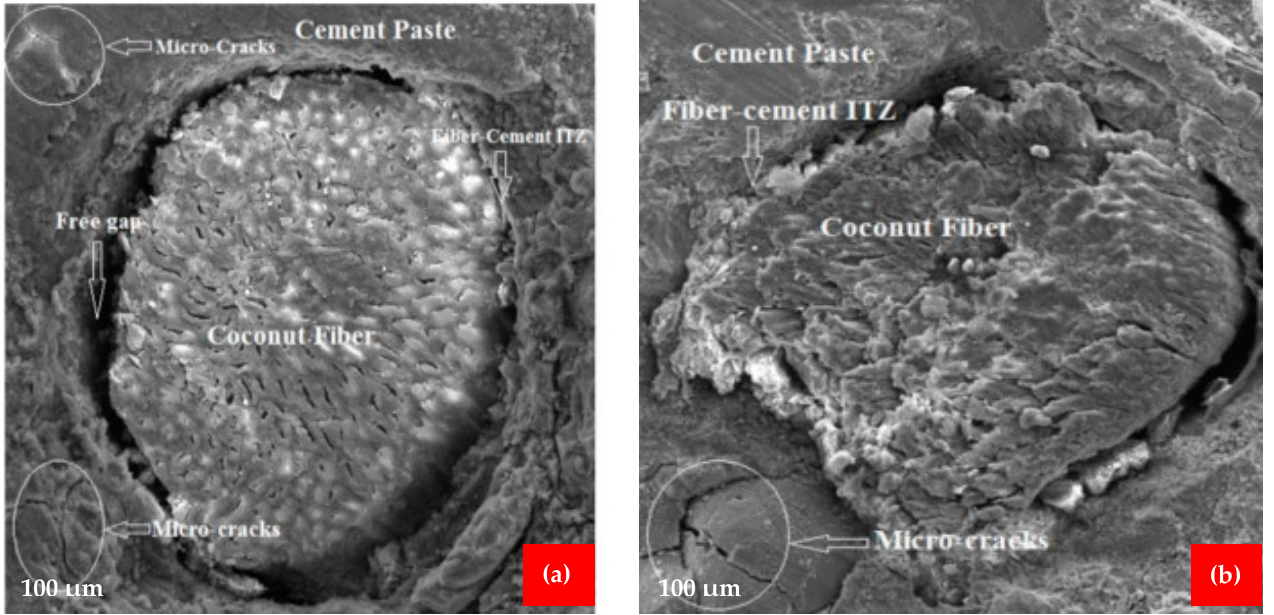
Figure 16. SEM of ( a ) free space between cement paste ITZ and micro cracks, ( b ) micro cracks, and CF paste [50].